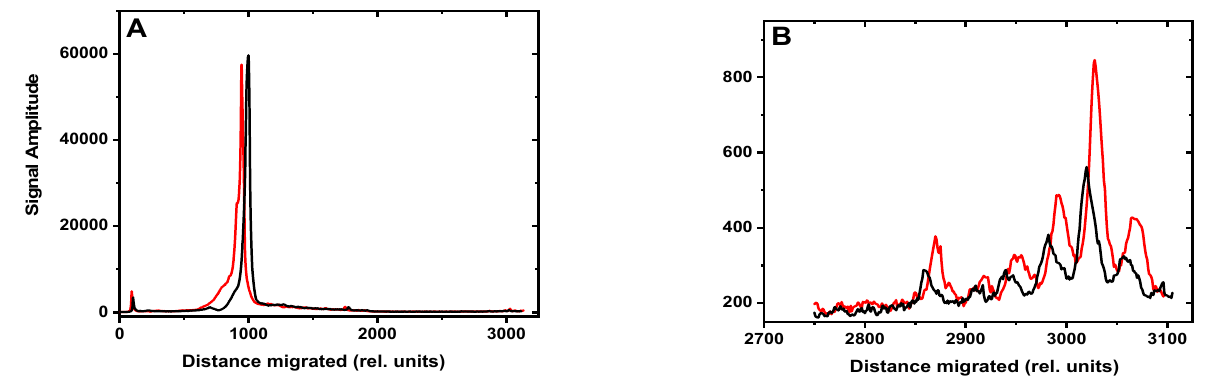
Figure 5. BP ‐ dG adduct sample. Example of a densitometry scans of the 30 min incubation time lane derived from BRBE ‐ pretreated (red trace) and untreated (black trace) HeLa cell extract NER product profile (data from Figure 4. Panel ( A ): Trace of the entire lane, from top to the bottom of the gel. Panel ( B ): ×100 amplification of the lower region of the lanes containing the ~24–30 nt oligonucleo ‐ tide dual incision NER excision products (Figure 4).